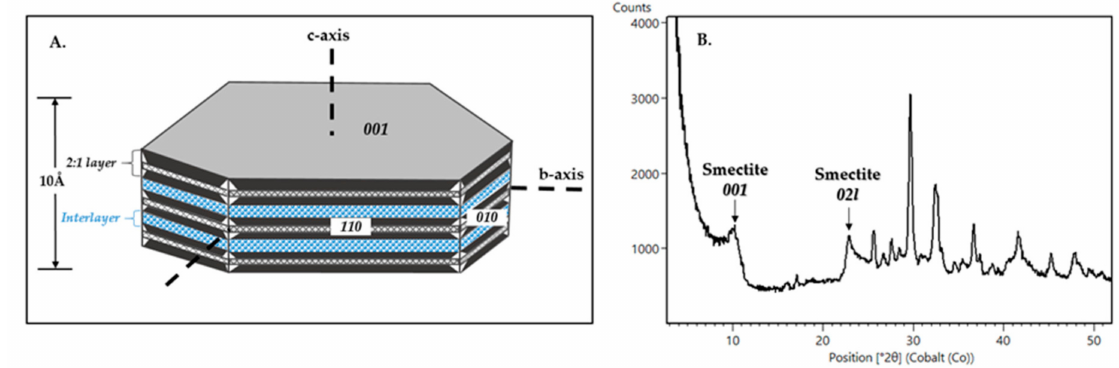
Figure 7. ( A ) Smectite structure demonstrating the c-axis and b-axis of a collapsed smectite structure with d(001) at 10Å. ( B ) CheMin XRD pattern from drilled martian sample “Glen Etive” (GE) from the Knockfarril Hill member of the Murray formation showing the d(001) and d(02l)